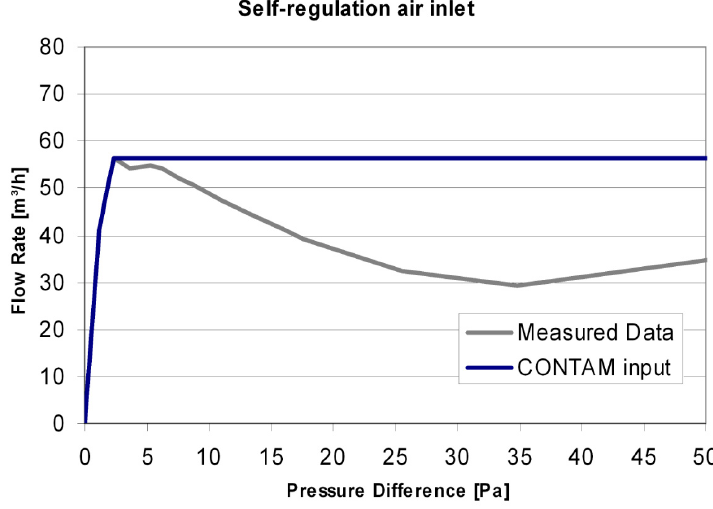
Figure 14. Comparison of Trickle Vent performance through CONTAM and experiment [78].